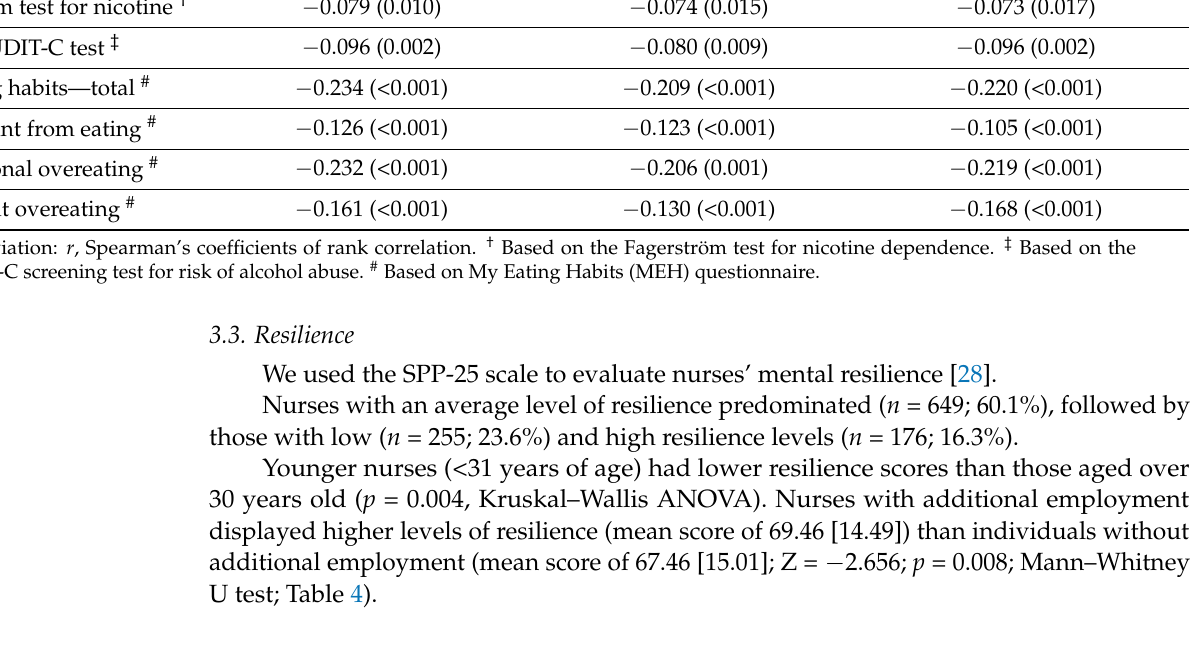
Table 3. Correlations between the wellbeing of Polish nurses and their smoking, drinking, and eating habits.